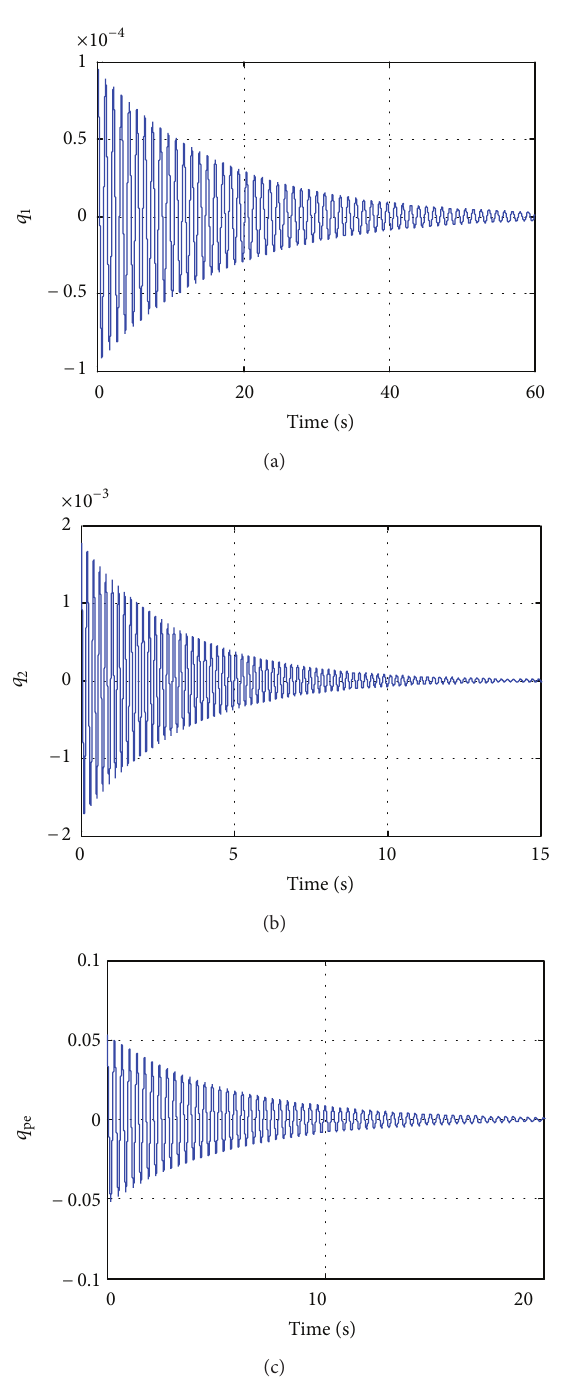
Figure 5: Feedback linearisation: response at 80 ms −1 (assumed- modes coordinates).